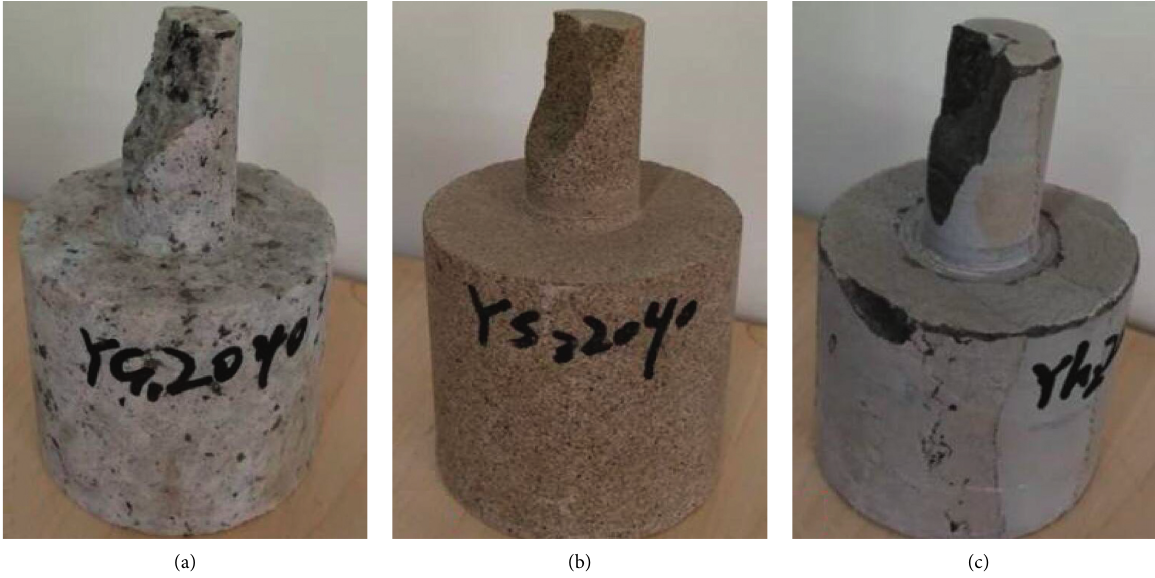
Figure 13: Core columns under impact: (a) sandstone; (b) limestone; (c) granite.